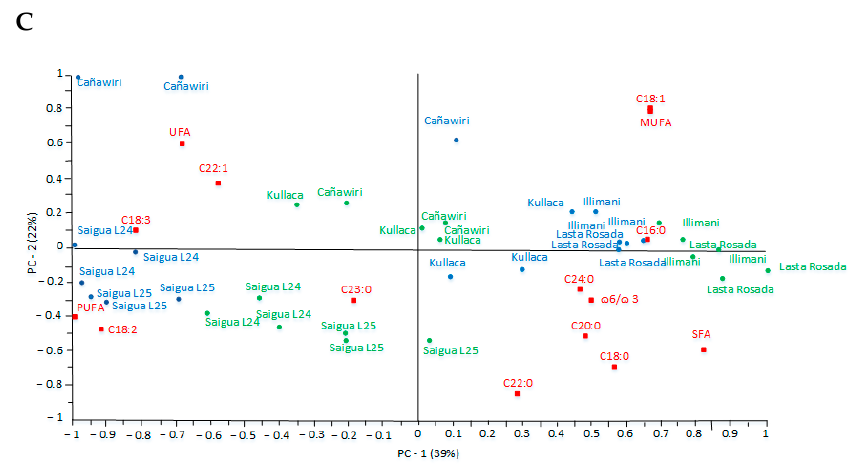
Figure 3. Principal Component Analysis (PCA) biplot of six cultivars of whole and dehulling canihua ( Chenopodium pallidicaule ). ( A ) Proximate composition. ( B ) Mineral composition. ( C ) Fatty acid composition. Blue: whole grains, green: dehulled grains.